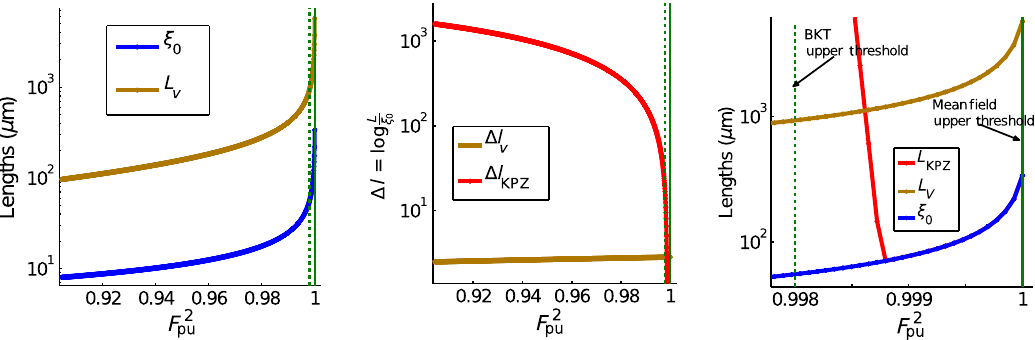
FIG. 5. Characteristic length scales in the WA regime. Left and right panels: Healing length ξ 0 (blue line), length scale for the vortex- dominated disordered phase L (brown line), and the KPZ length scale L (red line) as a function of the pump strength (normalized to v KPZ ≡ F =F up p ). The vertical dotted (green) line indicates the BKT transition where V-AV pairs proliferate (taken the upper threshold, F pu p from Ref. [33]), and the vertical solid (green) line shows the mean-field OPO threshold. We use the same parameters as those discussed 0 , k 1 . 4 , and k 0 . 1 . The two different panels correspond to two in the text for the bad microcavity at zero detuning δ CX ¼ p ¼ s ¼ different ranges in pump strength. Central panel: Logarithmic RG scale for the vortex-dominated phase ( Δ l ) and for the KPZ phase v ( Δ l ) as a function of pump strength normalized to the pump at the upper threshold (vertical solid green line). The vertical dotted KPZ green line indicates the BKT transition. Note that L is expected to be strongly renormalized close to the threshold as explained in v Appendix B.